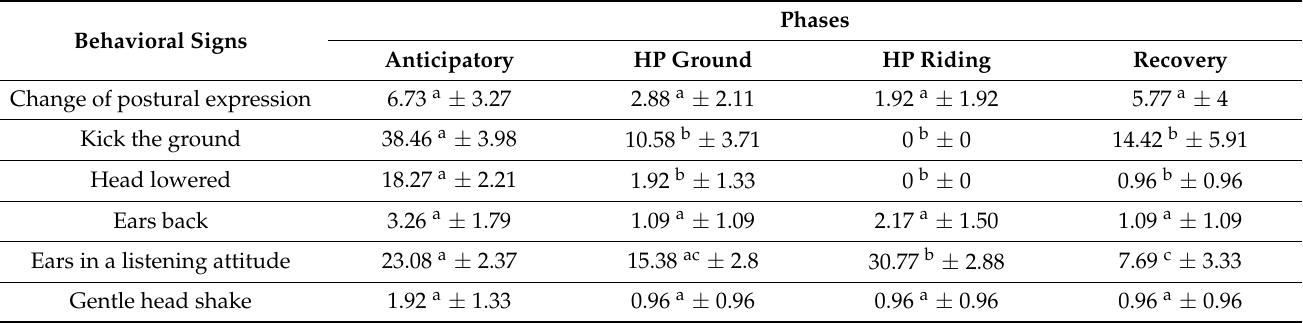
Table 5. Mean values (%) ± SEM of the behavioral parameters that are related to stress in the horses in the anticipatory phase, the HP ground and HP riding phases (horse-patient interaction on the ground and on horseback, respectively) and the recovery phase.